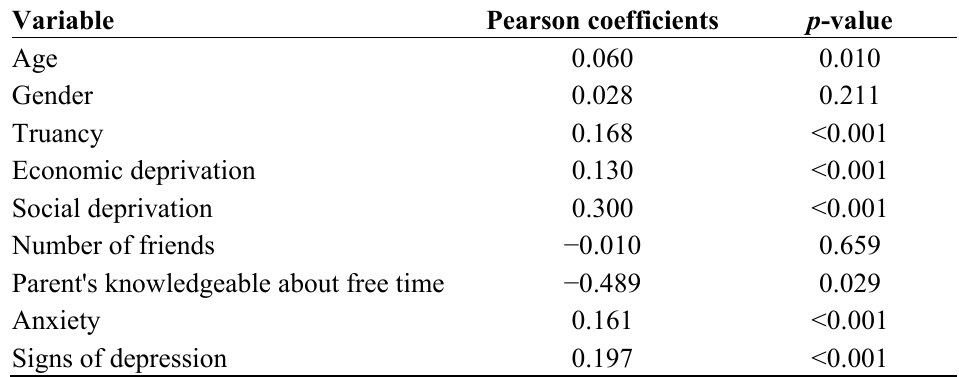
Table 1. Pearson correlation coefficients between bullying and selected variables.